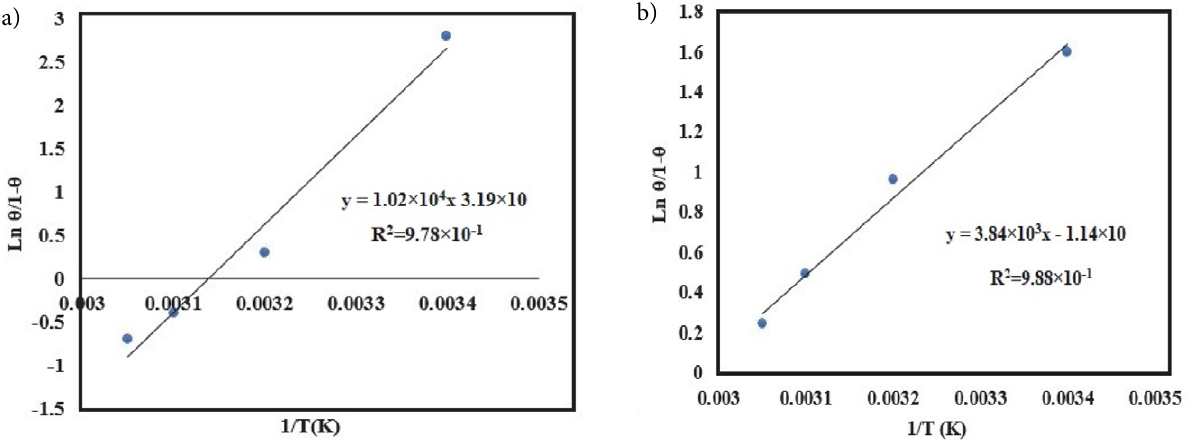
Figure 8. Plots of ln (θ/1–θ) versus 1/T for mild steel in a) hydrochloric acid solution containing 300 ppm of inhibitor and b) sulfuric acid solution containing 300 ppm of inhibitor, at different